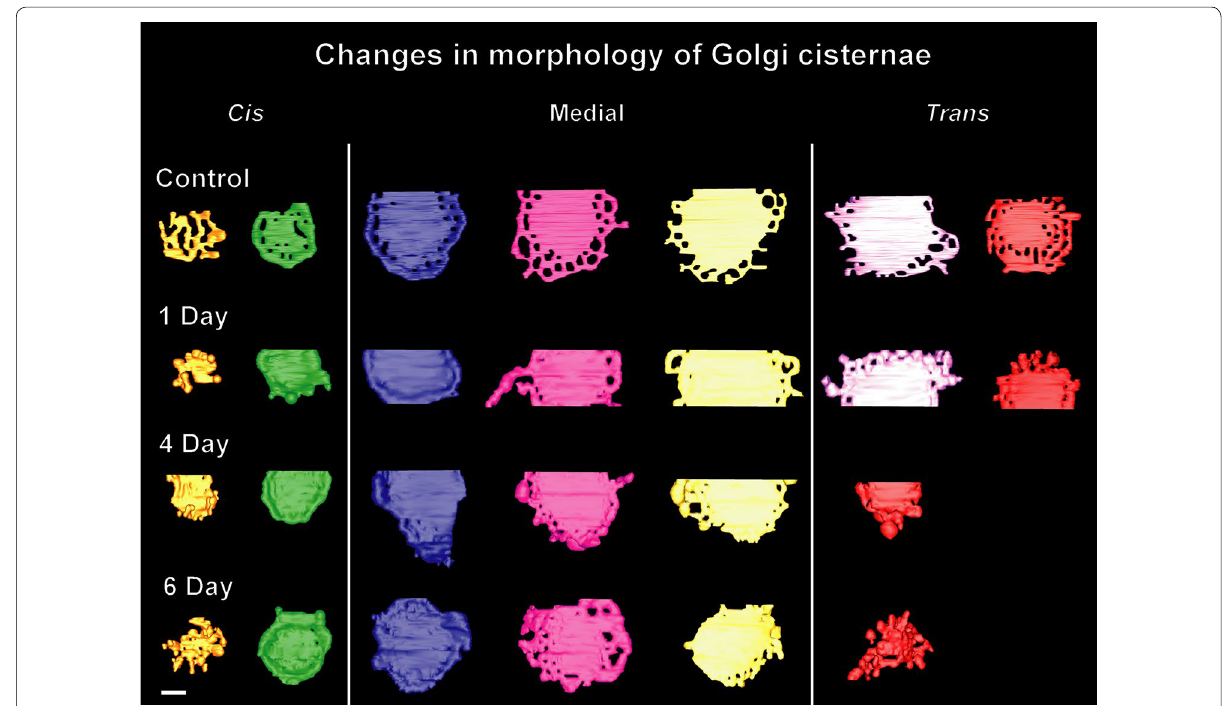
Fig. 7 Gallery of tomographic reconstructions of Golgi stack cisternae of control and stimulated Venus flytrap gland cells. The individual cisternae (C1–C7) are viewed from the cis -side of the stacks. The C1 cis -cisternae exhibit the greatest variability in size and architecture. Control (non-stimulated) Golgi cisternae typically possess many peripheral fenestrae, whereas the BSA-stimulated Golgi possess few. BSA stimulation also caused a reduction in the number of cisternae (days 4, 6) and an increase in size of the bulbous cisternal margins that give rise to budding secretory-type TGN vesicles. Bar 0.2